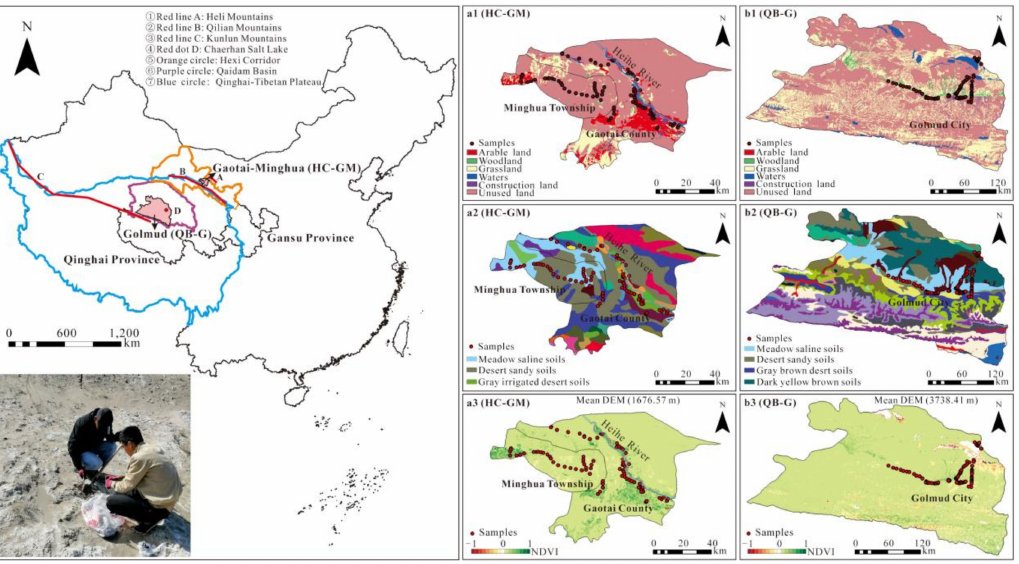
Figure 1. Distribution of the samples in HC–GM and QB–G, including their ( a1 , b1 ) land use